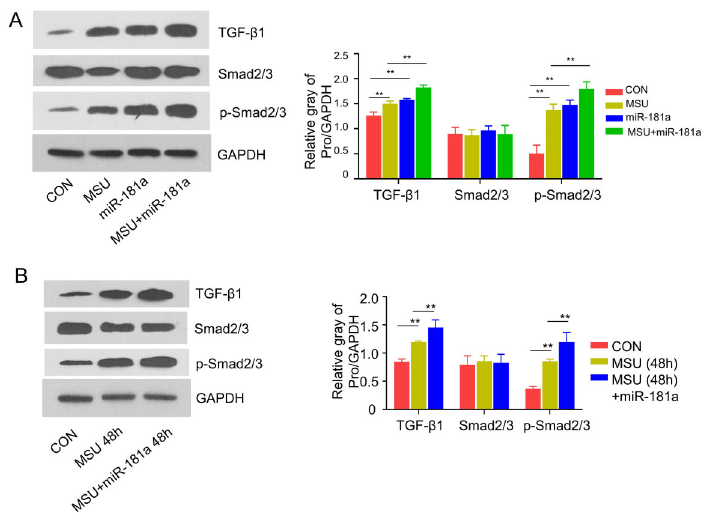
Figure 2. miR-181a overexpression promotes TGF- b 1/Smad signaling activation. A , Protein levels of TGF- b 1, Smad2/Smad3, and p-Smad2/Smad3 were measured in Tregs from control (CON) mice and monosodium urate (MSU)-induced mice at 24 h, in the presence or absence of miR-181a mimic. B , Protein levels of TGF- b 1, Smad2/Smad3, and p-Smad2/Smad3 were measured in Tregs from both groups at 48 h, in the presence or absence of miR-181a mimic. Data are from three independent western blots. Data are reported as means ± SD. **P o 0.01